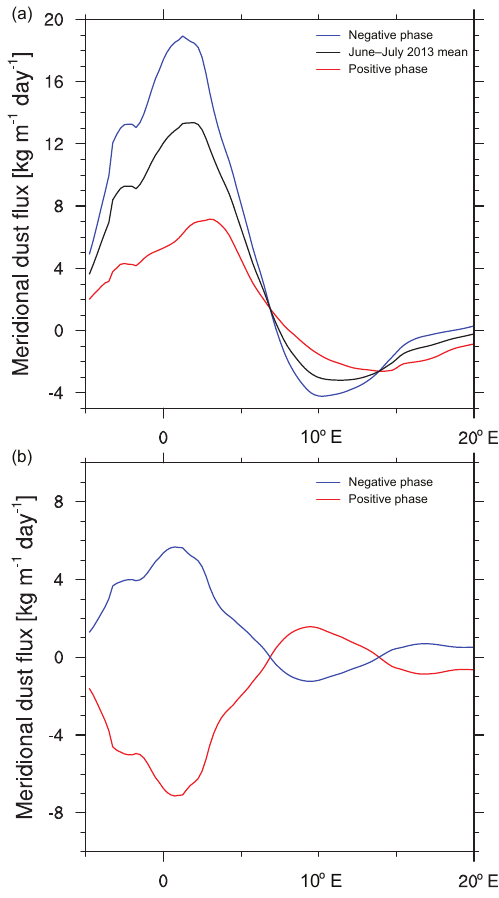
Figure 10. (a) Composite of the vertical totals of the merid- ional dust flux at 37 ◦ N (kgm − 1 d − 1 ) for positive (red) and neg- ative (blue) phases of the first EOF for June–July 2013 as well as the June–July 2013 mean flux. Panel (b) shows the difference (kgm − 1 d − 1 ) regarding the June–July 2013